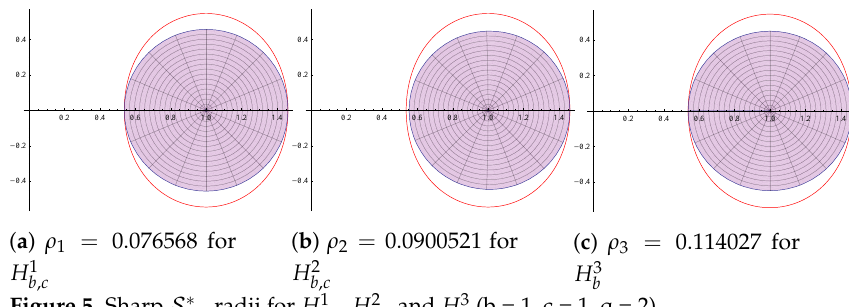
, H 2 and H 3 (b = 1, c = 1, q = b , c b , c b